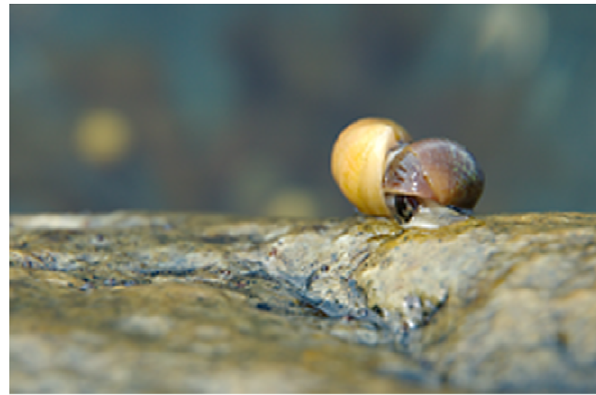
Figure 1. A copulating pair of Littorina ( Littorina saxatilis of Swedish S ecotype). The female is attached to the substratum while the male is positioned on the right-hand side of her shell, inserting his penis under her shell. Photo: Patrik Larsson.